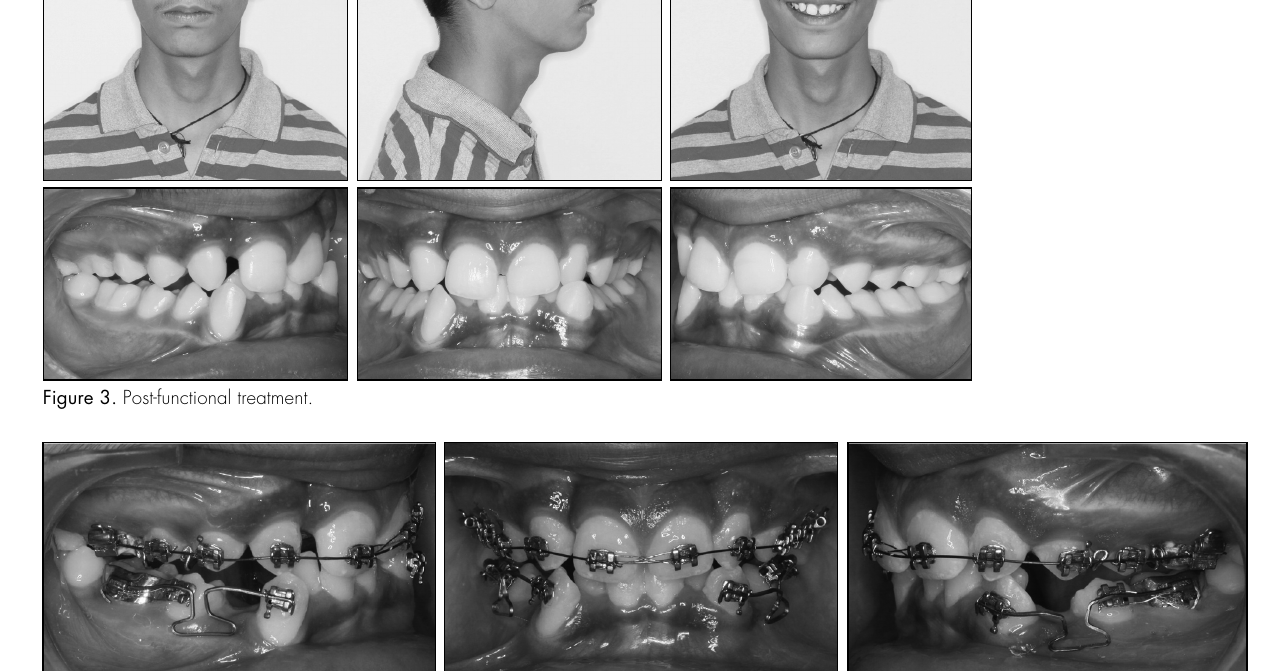
Figure 4. Lower first premolar extraction with segmental canine